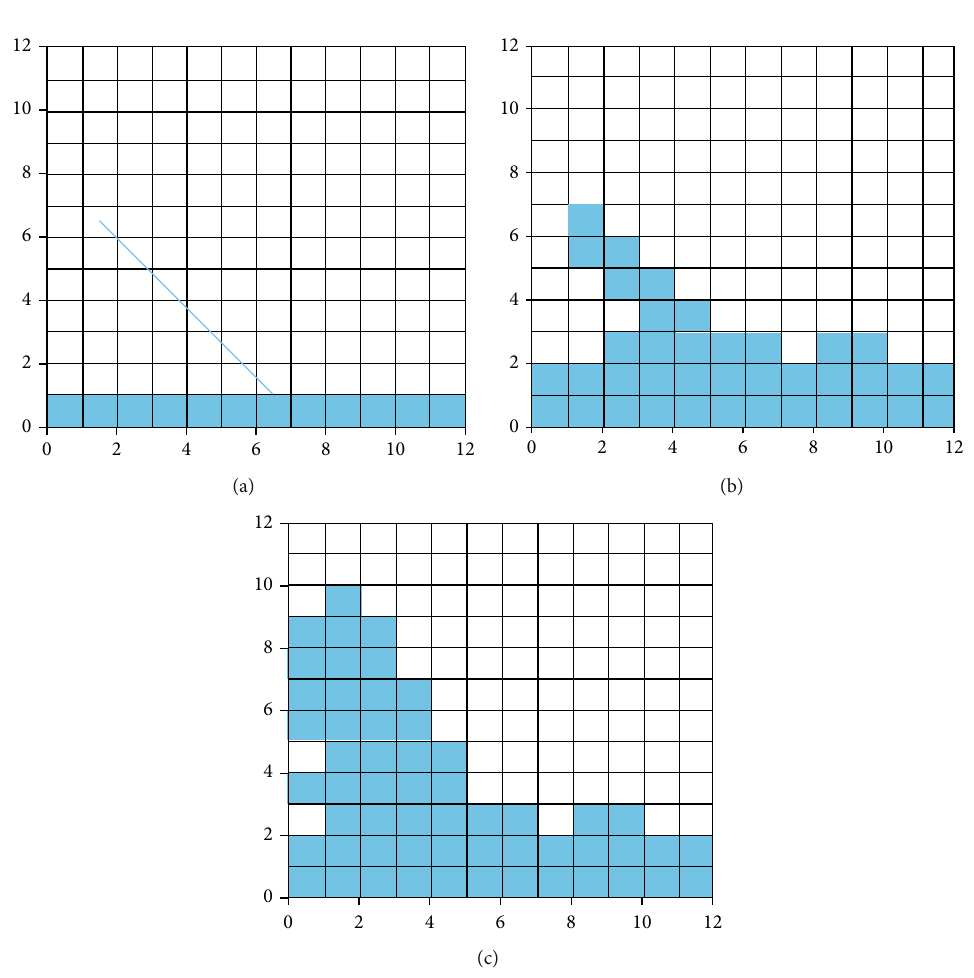
Figure 5: Imbibition process in 2D grid cells by percolation theory: (a) step 1, (b) step 3, and (c) step 6. White and blue cells represent these without and with water; the blue line represents a